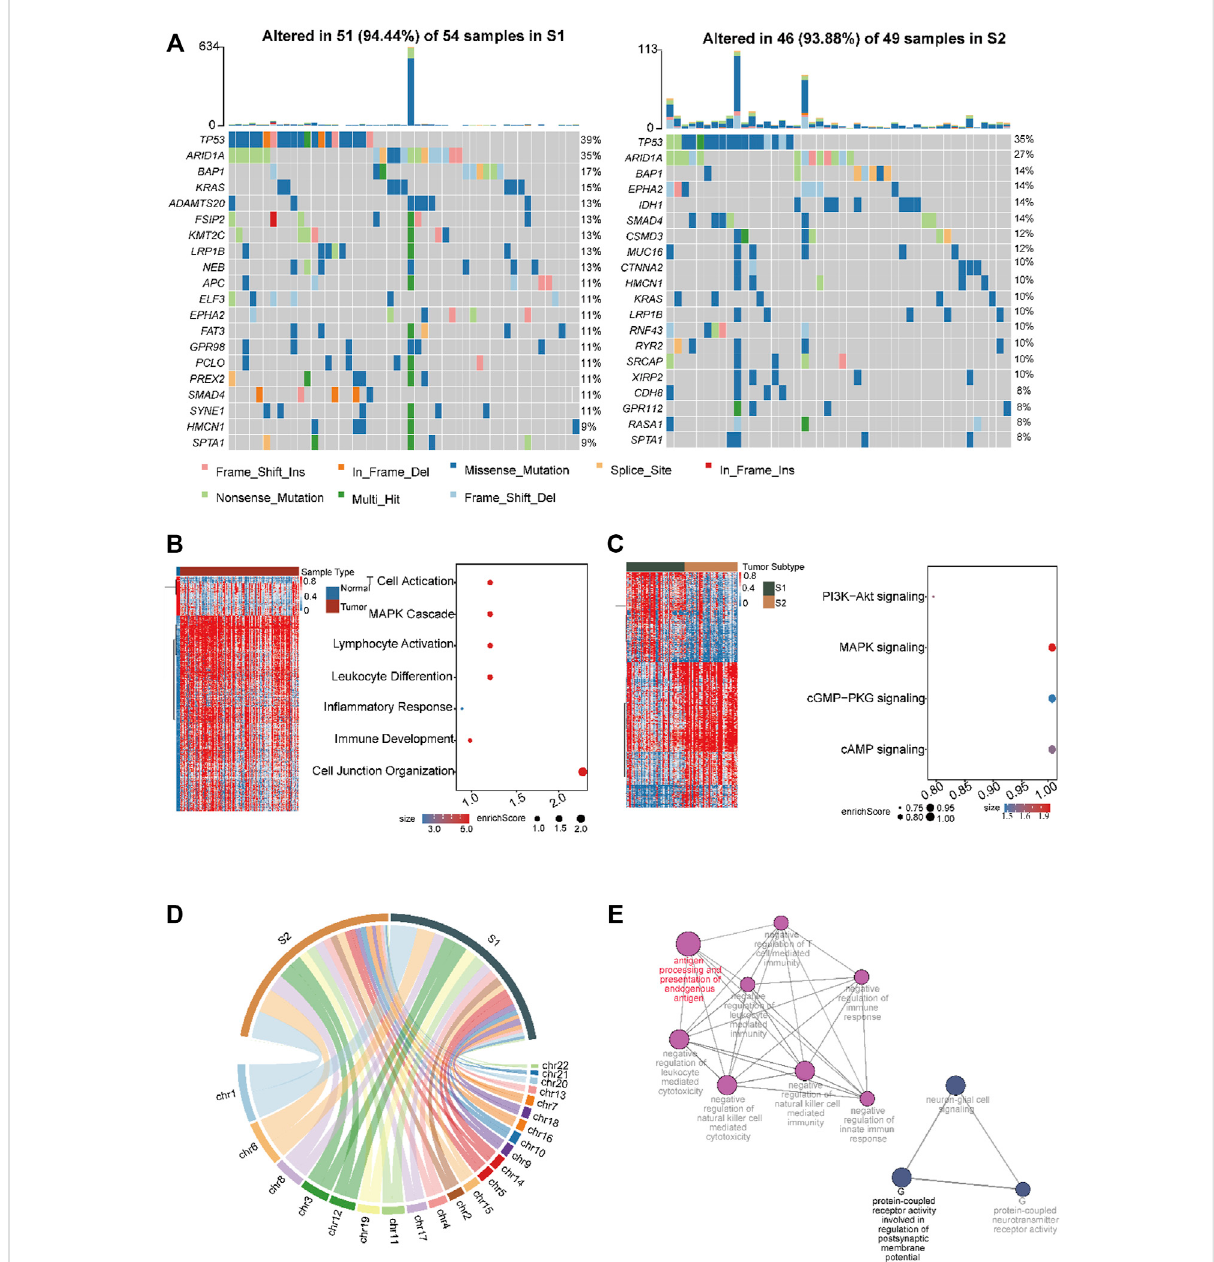
FIGURE 5 Investigationofthemutationpro fi leinter-tumorheterogeneitypro fi lesinthetwoCCAsubtypes. (A) Thetop tenmutatedgenesacrossthetwo subtypes. The colors of rectangles in the body of the heat map indicate different types of somatic mutations and the key identifying each mutation type is shown at the bottom below the color bar. The bar plot on the top shows the counts of mutations for each patient and the colors in the bar plots correspond to the colors showing mutation types in the body of the heat map. The title of the heat map showing the mutation sample number in each subtype including ampli fi cation, missense mutations, and deep deletions. The left number showing the gene mutation frequency in thetwosubtypes. Heatmapanddotplotshowingthedifferentiallyexpressedgenesandthesigni fi cantlyenrichedpathwaysinnormal (B) andcancer tissue (C) in CCA. Color gradient blue to red indicates relative expression levels from low to high. Dot size represent enrichment scores. (D) Circos plot showing the ampli fi cation and deletion regions in the two subtypes. The width of the plot indicated the CNV mutation regions numbers in each subtype across the chromosomes. (E) Network showing enriched pathways of hypo-methylated genes that occur on chromosomes 6 and 8 in S2. Dot size represents the enrichment